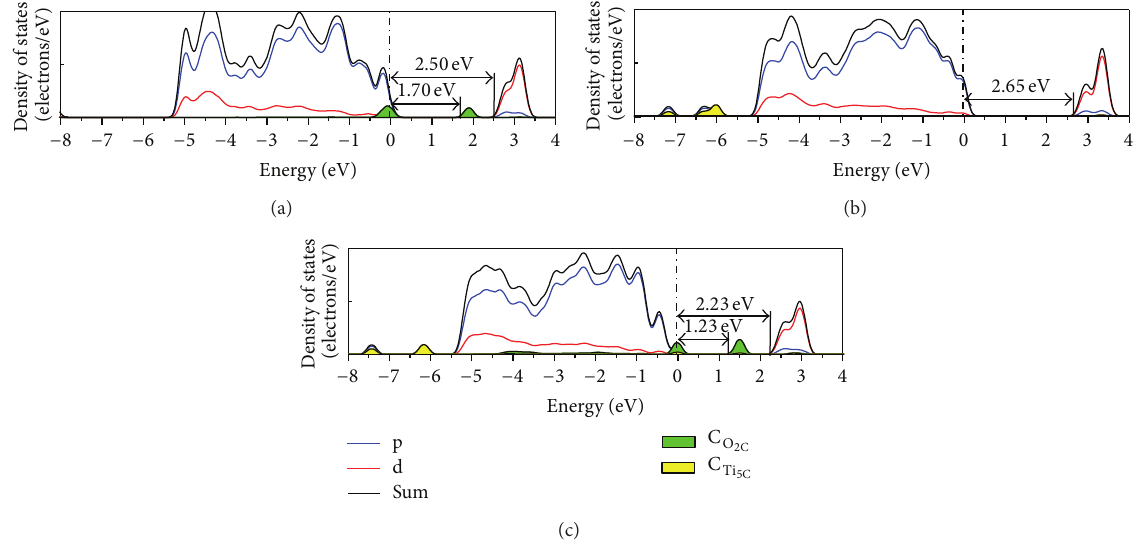
Figure 6: Density of the states (DOS) calculated for C-doped surfaces: (a) Ti 24 O 47 C(A-CTO), (b) Ti 23 CO 48 (C-CTO), and (c) Ti 23 CO 47 C(AC- CTO). Fermi level is at 0 eV and 𝑈 is 8.50 eV for Ti 3d electrons. The 2p states of C dopant at O 2 represented by dark grey and black area,